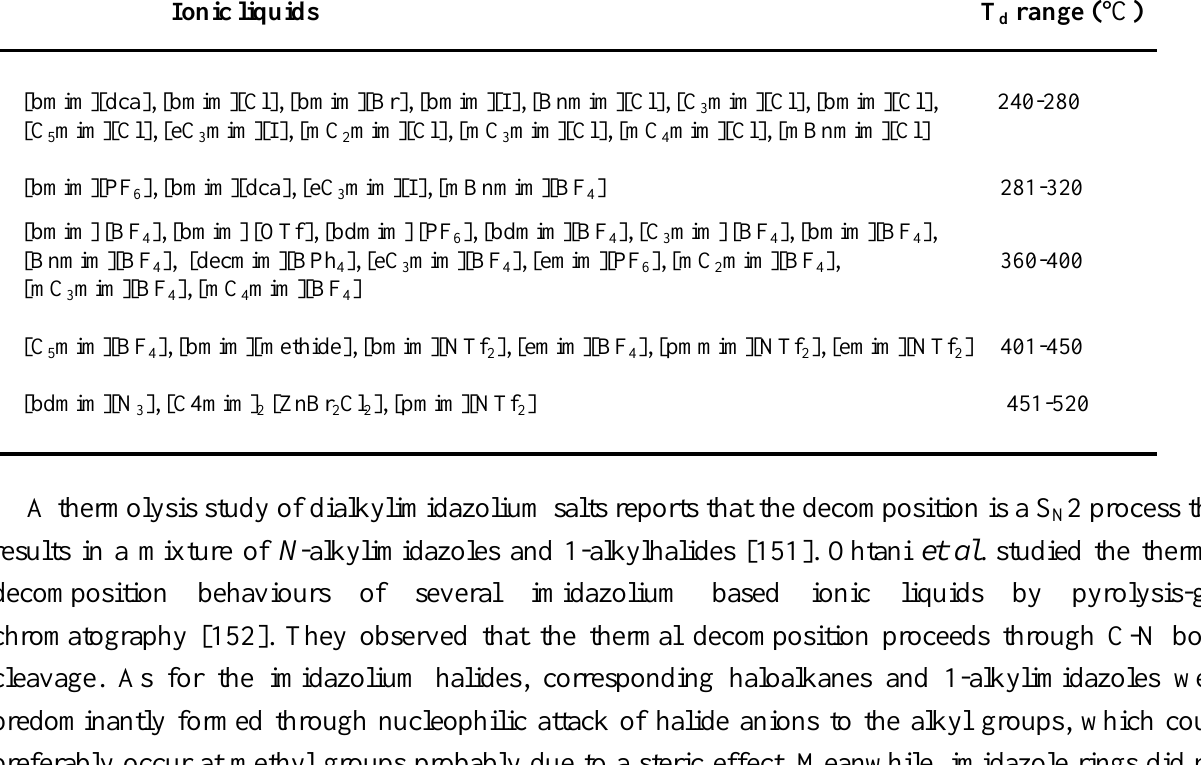
Table 8. Range of T